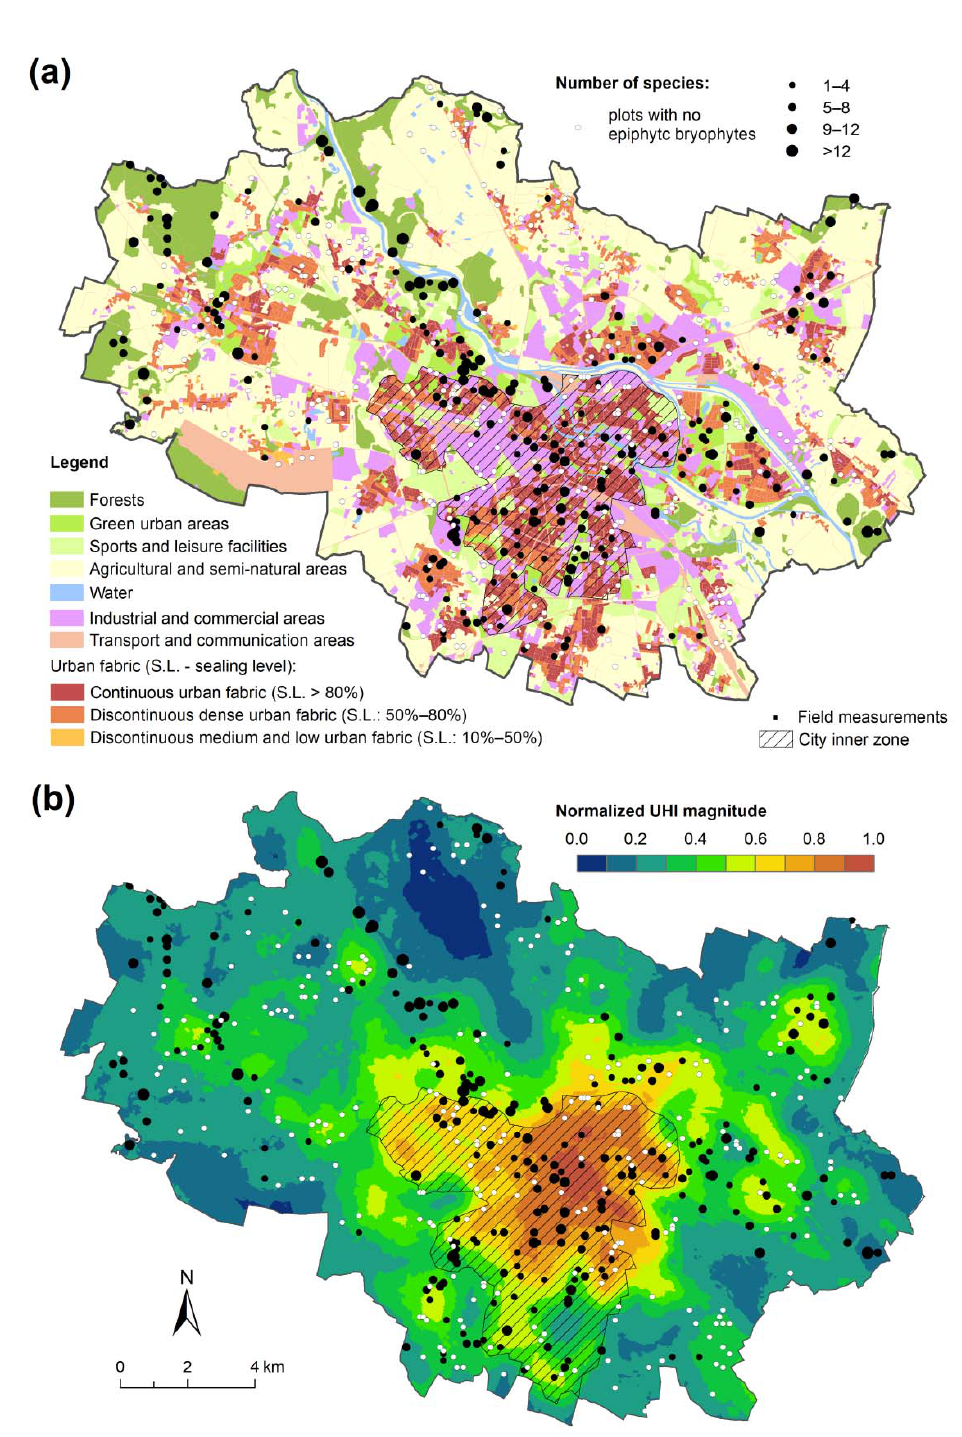
Figure 2. Number of species recorded in the study plots on the background of the urban landscape elements (map ( a )) and urban heat island magnitude (map ( b )).